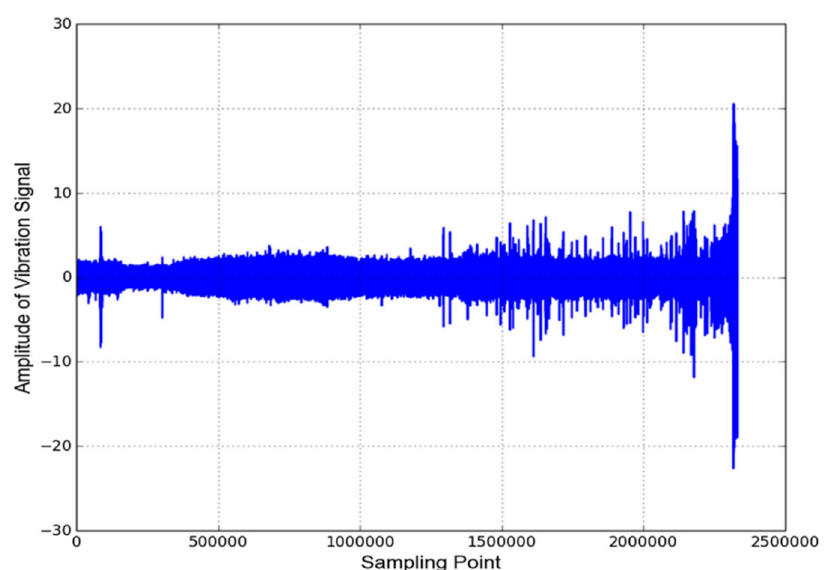
Figure 3. The PRONOSTIA time series data [41].